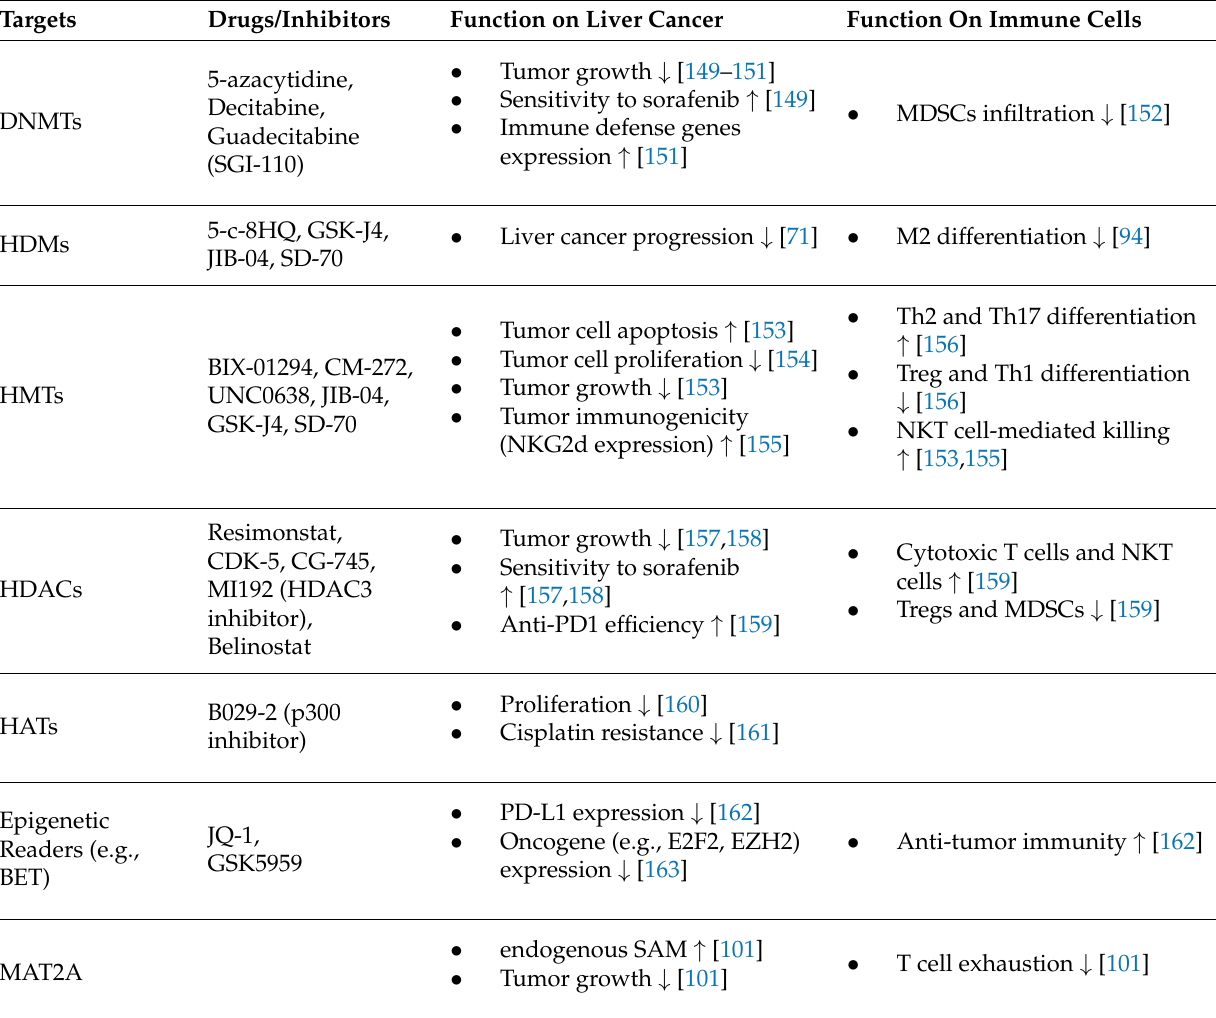
Table 3. Epigenetic targets tested in vitro and/or in vivo for liver cancer and immune